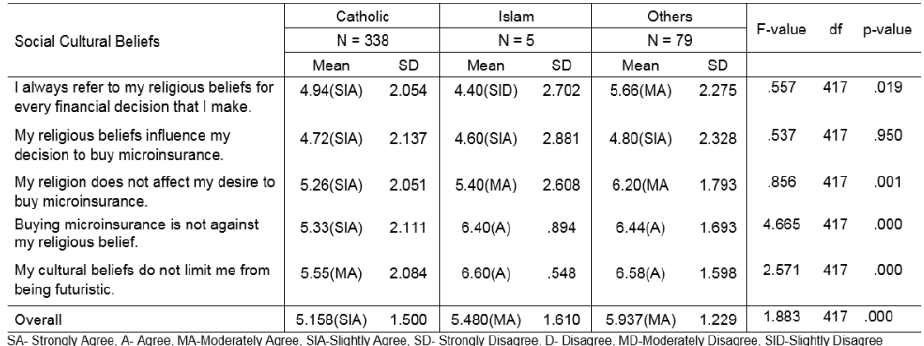
Table 6: Level of Agreement of the Respondents on the Social Cultural Beliefs on Microinsurance According to Religion